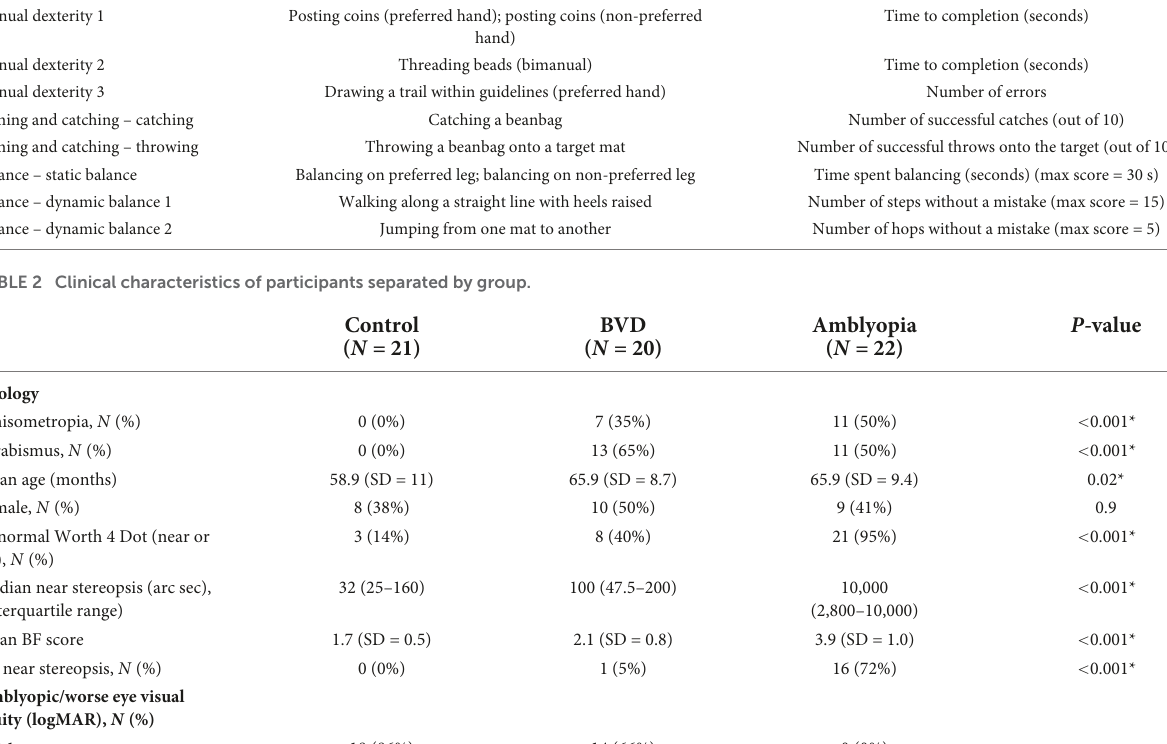
TABLE 1 Individual tasks from each category of the MABC-2 for 3–6-year-old children. Category